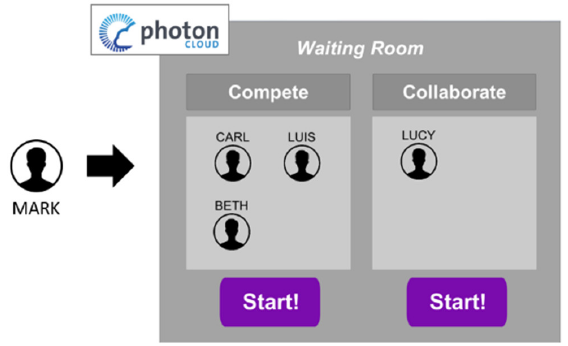
Figure 3. A schematic representation of the application interface. The user ‘Mark’ logs in and joins the ‘Waiting Room’ in which other players are already present.